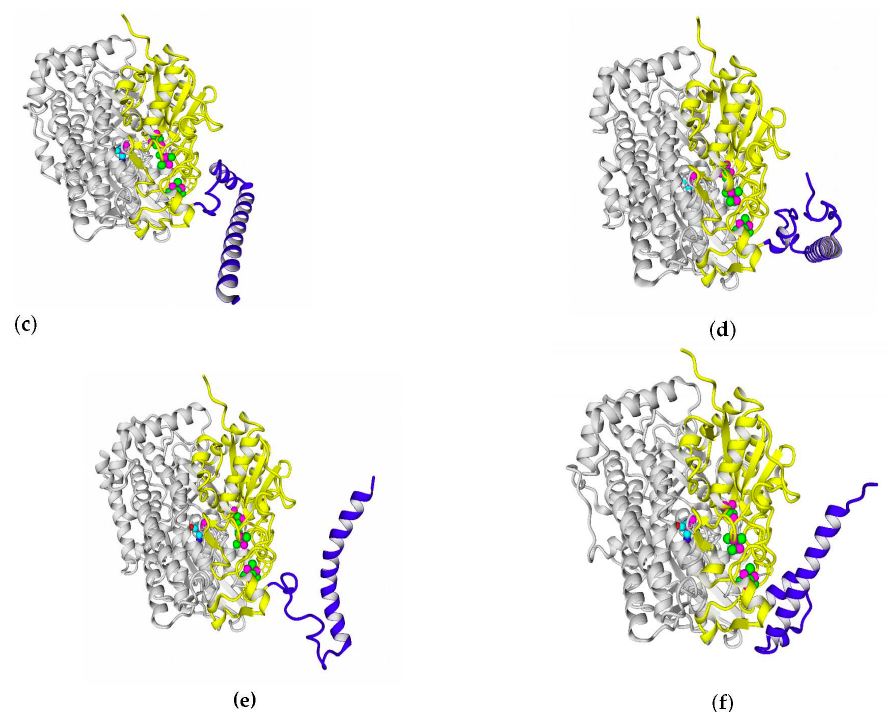
Figure 8. Full-size models of HupSL hydrogenases. Ab initio modeled fragments are colored blue. The panels of the figure correspond to the following HupSL enzymes: ( a ) Tca. roseopersicina ; ( b ) Rba. capsulatus ; ( c ) Rba. sphaeroides ; ( d ) Rps. palustris ; ( e ) Rvi. gelatinosus ; and ( f ) Rsp. rubrum .